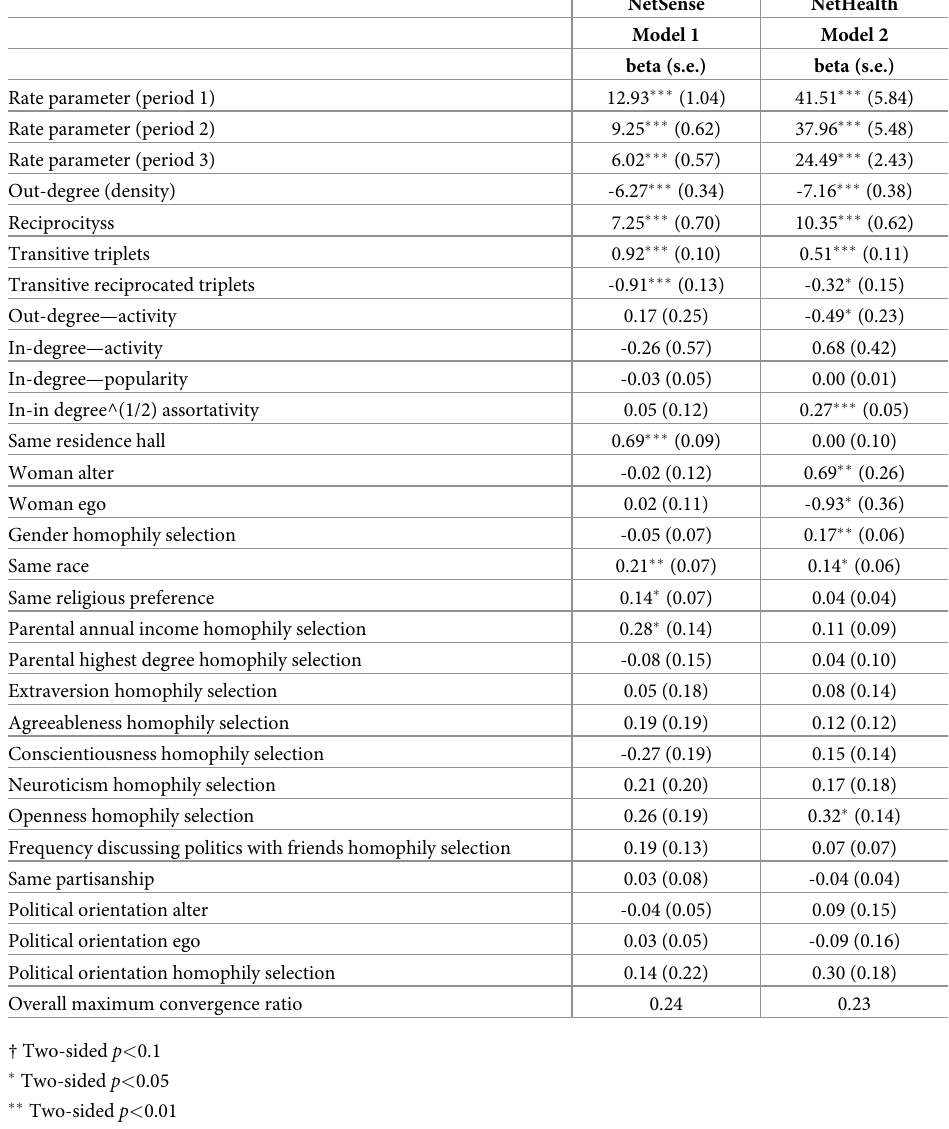
Table 7. The network equation in estimated SAO models for the NetSense and NetHealth study